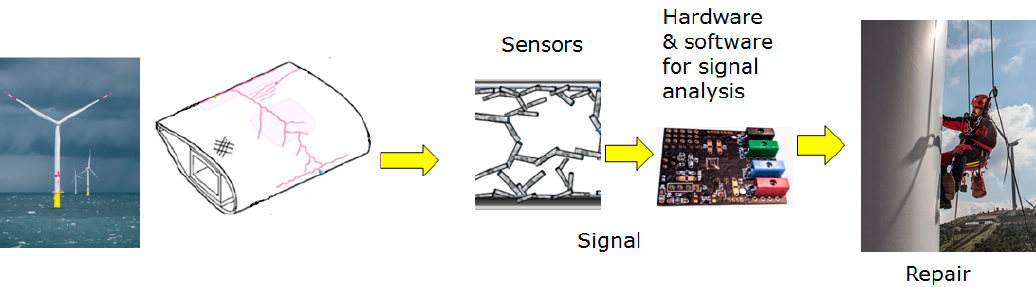
Figure 1. Schema: from blade damage via SHM to repair: wind turbine → damage in laminate → embedded or attached sensors—monitoring system → repair.